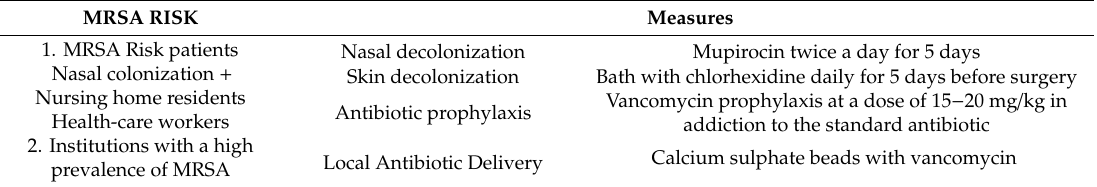
Table 1. Preventive Measures in High-Risk Patients ( > 130 pts) with Additional Methicillin-Resistant Staphylococcus aureus (MRSA)